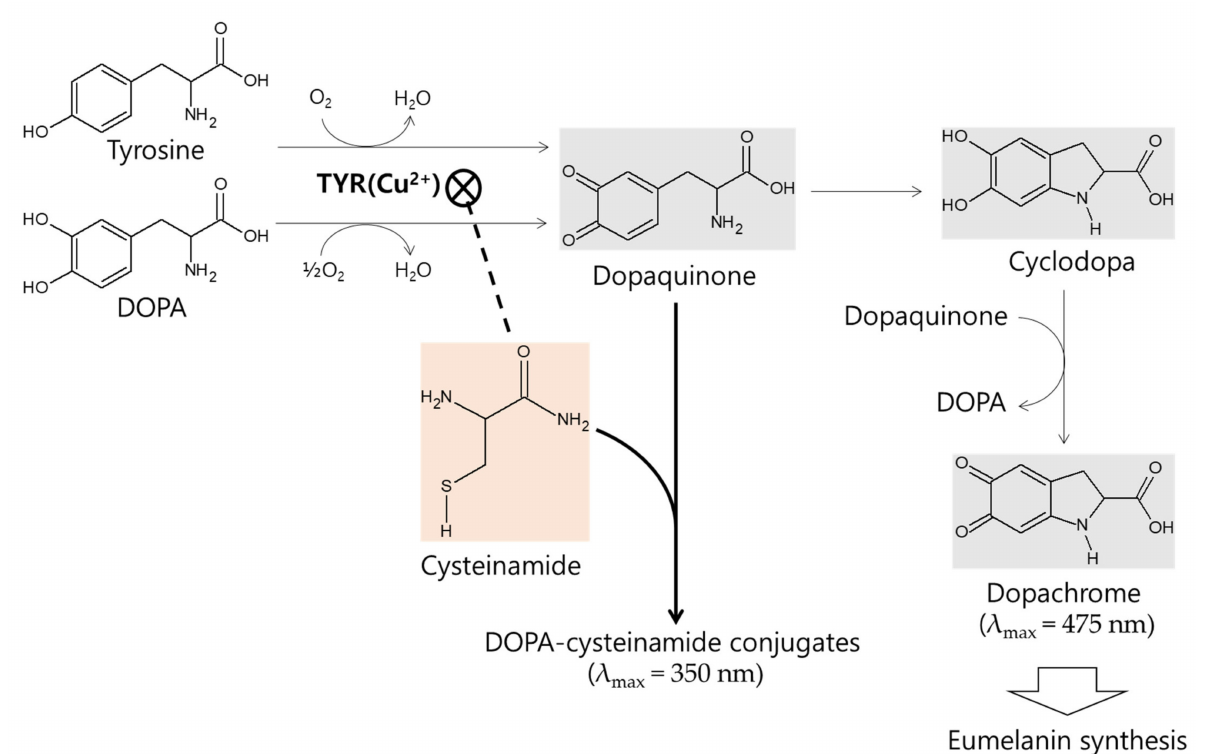
Figure 12. A tentative model for anti-eumelanogenic or anti-melanogenic action of L-cysteinamide. L-DOPA or L-tyrosine is oxidized by TYR to dopaquinone, which is spontaneously converted to cyclodopa and then oxidized to dopachrome. L-Cysteinamide binds the Cu 2+ ion at the active site of TYR and inhibits its activity. When TYR is partially inhibited by moderate concentrations of L-cysteinamide, dopaquinone synthesis is reduced but still occurs at significant levels. The synthesized dopaquinone is quickly captured by the available L-cysteinamide to form DOPA-cysteinamide conjugates, thus reducing dopachrome formation. If TYR is completely inhibited by high concentrations of L-cysteinamide, no dopaquinone is synthesized, and thus neither DOPA-cysteinamide conjugates nor dopachrome can be produced. Overall, it is proposed that L-cysteinamide may prevent eumelanin synthesis through a dual mechanism by inhibiting TYR activity, thereby reducing dopaquinone synthesis, and by diverting dopaquinone to the formation of DOPA-cysteinamide conjugates, thereby reducing dopachrome formation. At very high concentrations, L-cysteinamide might block total melanin (both pheomelanin and eumelanin) synthesis by almost completely inhibiting TYR